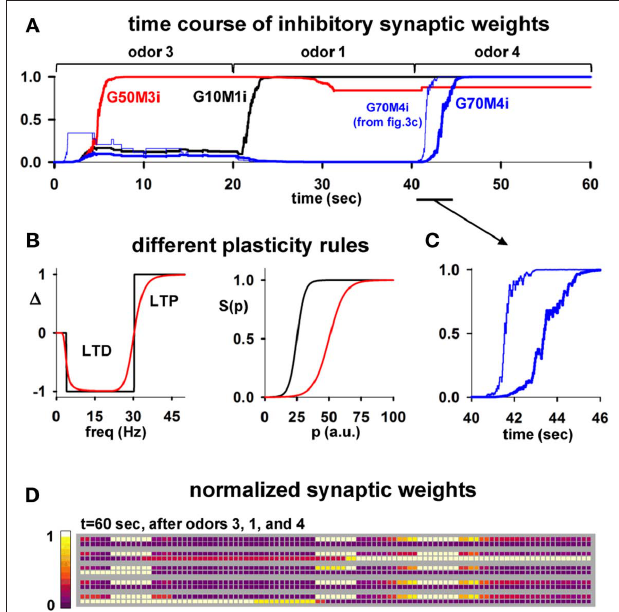
FIgure S1 | Cluster formation is robust to changes of the plasticity rule. (A) Time course of the same synapses as in Figure 3 during a simulation with the same stimulation protocol (odors 3, 1, 4 for 20 s each) but using a smoother frequency dependence for ∆ and a modified S ( p ) activation function; for comparison, the original trace for G70M4i from Figure 3 has been added. (B) The ∆ and S ( p ) functions used in the paper (black) and for this simulation (red curves). They were implemented